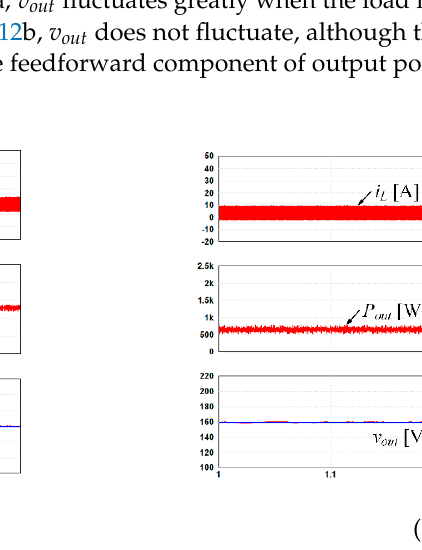
Figure 11. Simulation results of output voltage control of integrated OBC using the proposed MPC method. MPC method.